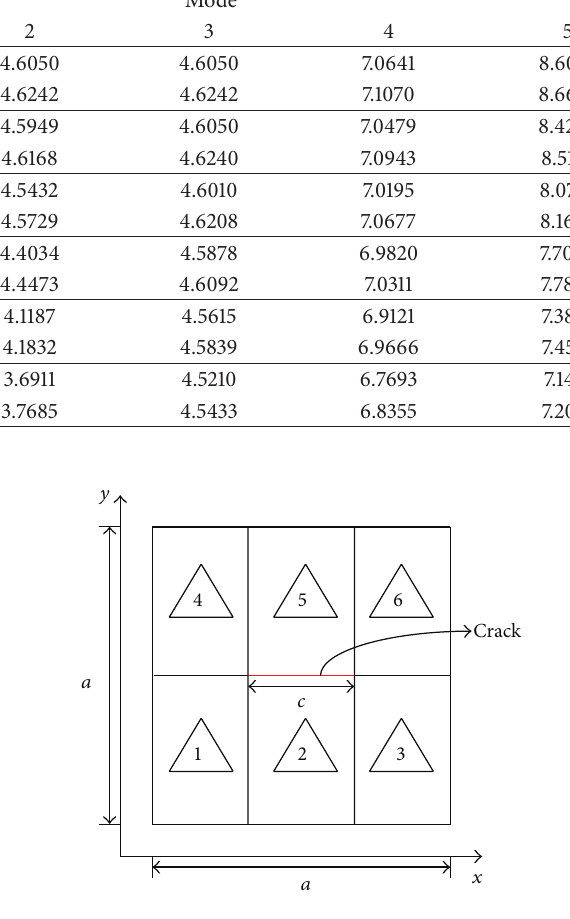
Figure 2: Modeling of cracked plates by the 𝑝 -convergent layerwise